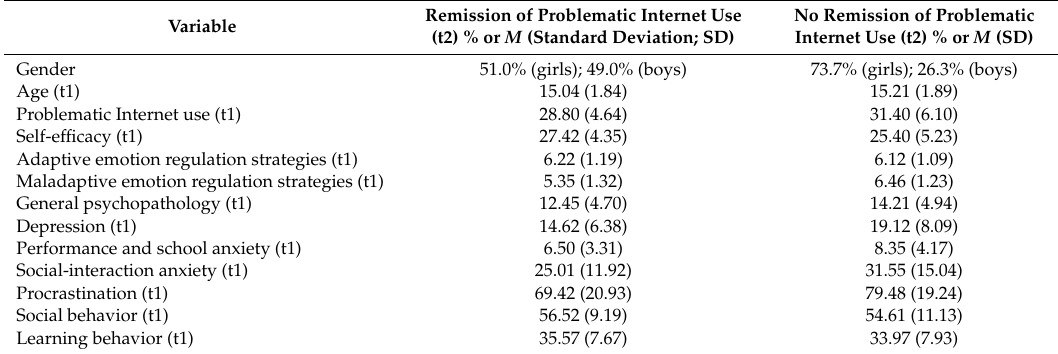
Table 1. Socio-demographic and psychosocial characteristics of adolescents with and without spontaneous remission of problematic Internet use at